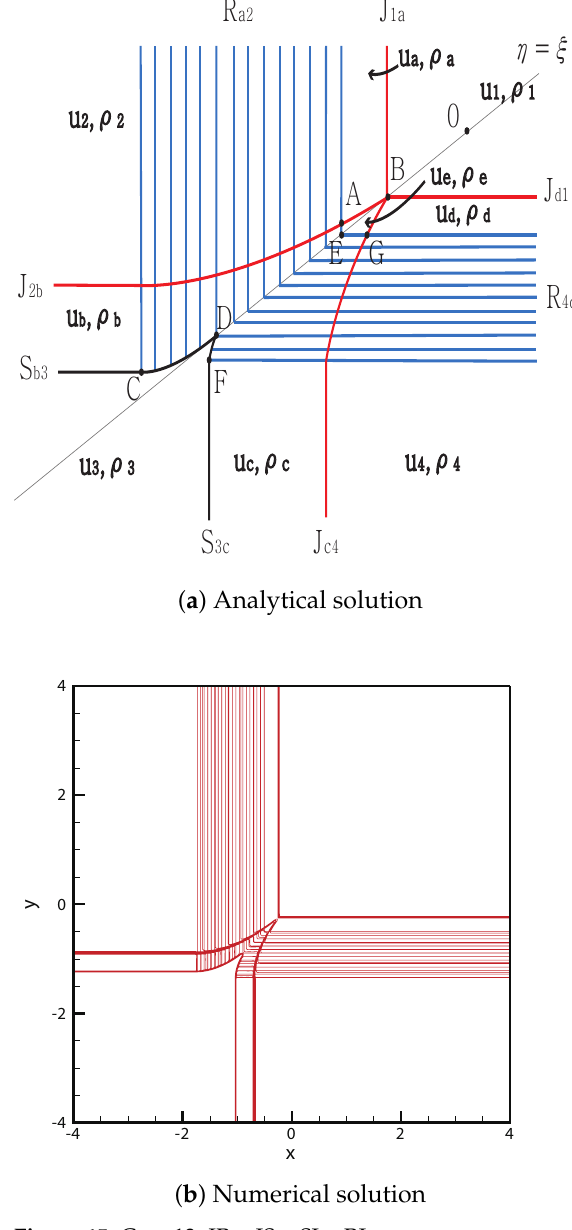
Figure 15. Case 13. JR + JS + SJ + RJ. Case 14. R + JS + R + JS ( u 2 < u 3 < 0 < u 1 < u 4